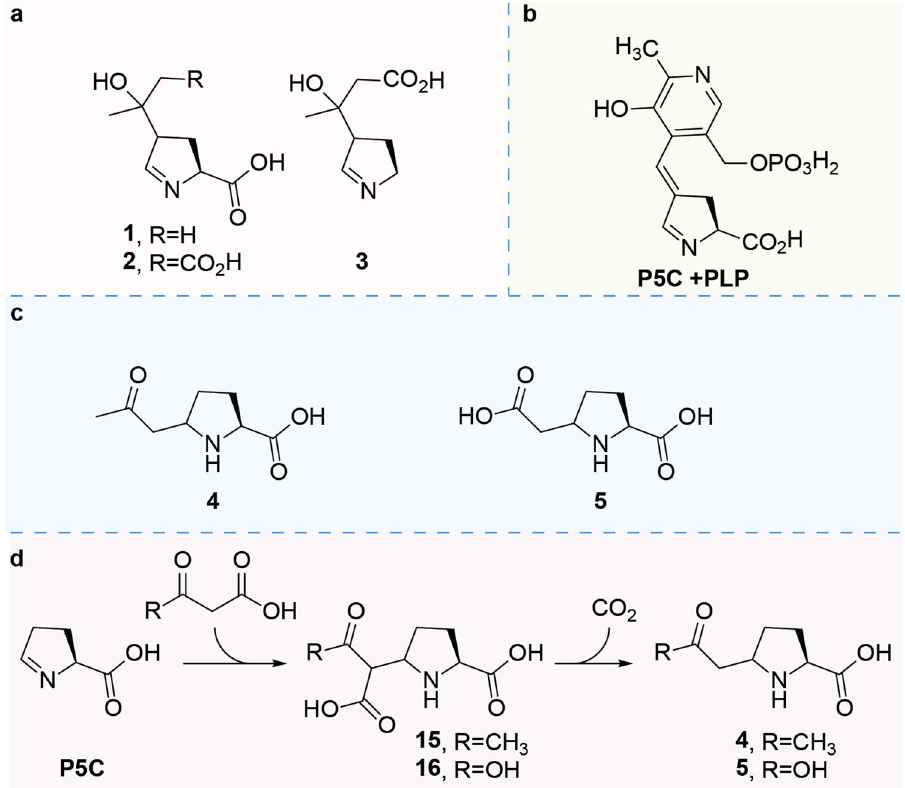
Fig. 5 Biomarkers identi fi ed for HPII. a Proposed molecular structure of the original detected reaction product of P5C with acetoacetic acid 6 . b Previously characterized adduct of P5C with PLP. c Biomarkers identi fi ed in this work. d Pathway of formation of the detected